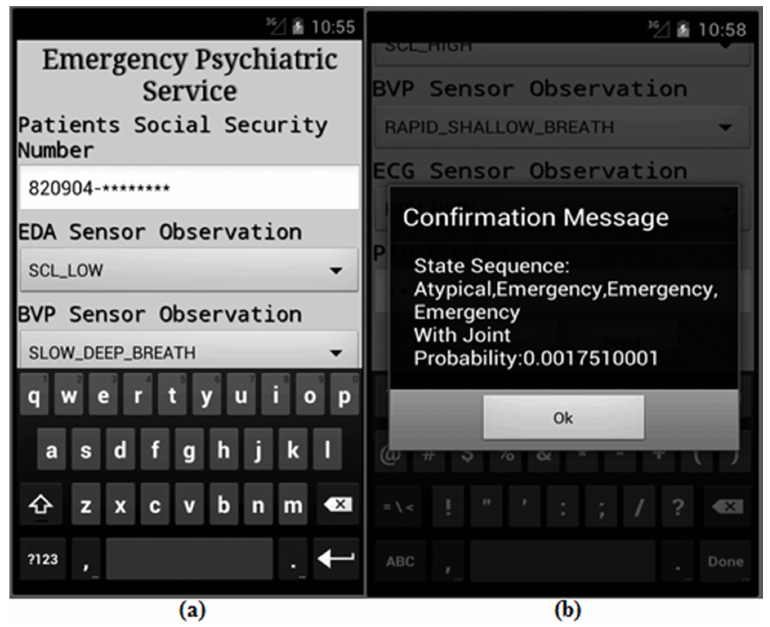
Figure 13. The AAL framework sends patient’s: ( a ) Biosensor observations; and ( b ) Returns an emergency psychiatric state sequence to the smart phone of a concerned psychiatrist.